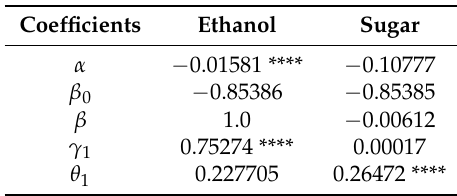
Table 2. The VECM for the ETH-SUG pair in P 1 . Significance levels: 10% (*), 5% (**), 1% (***) and 0.1%